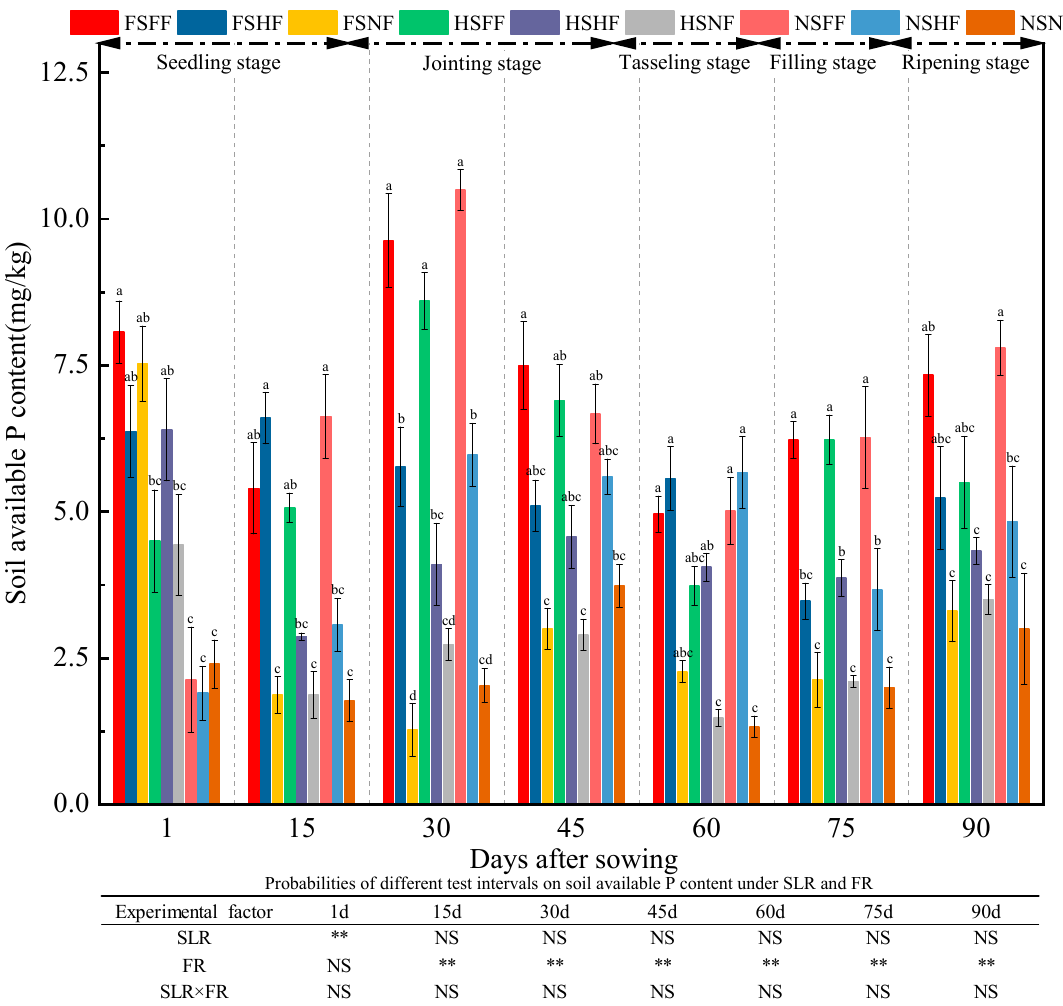
Figure 11. Effects of SLR and FR on soil AP content. Note: Bars represent means ± standard deviation ( n = 3) with different letters indicating significant differences based on LSD ( p ≤ 0.05). SLR, sugarcane leaf return; FR, fertilizer reduction.